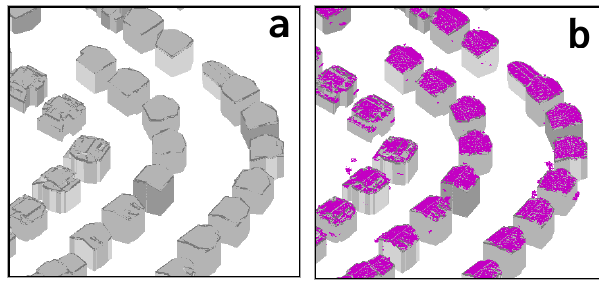
Figure 5. Automatic point based classification results of proposed approach (a) and 3D building models generated using building class points (b)